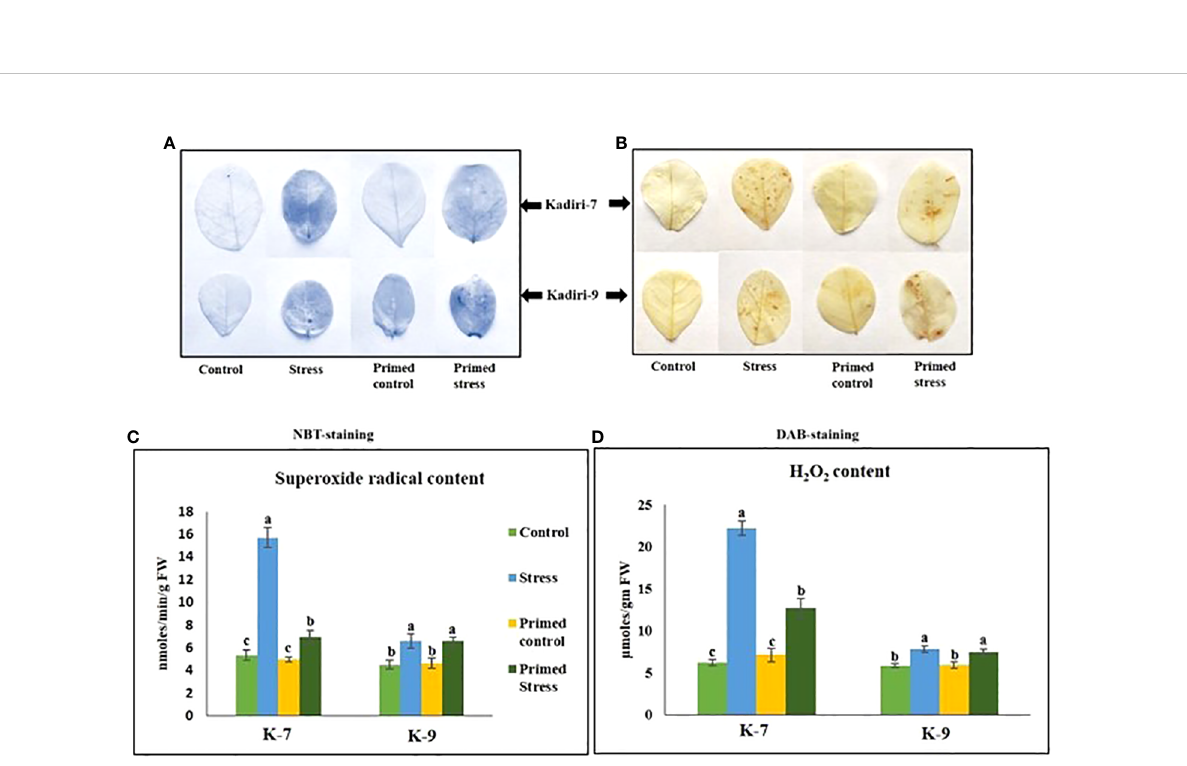
FIGURE 3 Effects of melatonin on the accumulation of superoxide radicals and hydrogen peroxide in the leaves of drought-sensitive (K-7) and drought- tolerant (K-9) varieties after different treatments. (A) Visualization of superoxide radicals in the leaves of different treatments by NBT-staining in K-7 and K-9 varieties; (B) H 2 O 2 accumulation detected by DAB staining in the leaves of K-7 and K-9 varieties after different treatments; (C) superoxide radical content and (D) H 2 O 2 content in the leaves of K-7 and K-9 varieties under stress condition. Data represents mean values ± SD of 3 independent experiments. Different alphabets within the group represent signi fi cant differences among treatments according to Duncan ’ s multiple range test at P < 0.05.